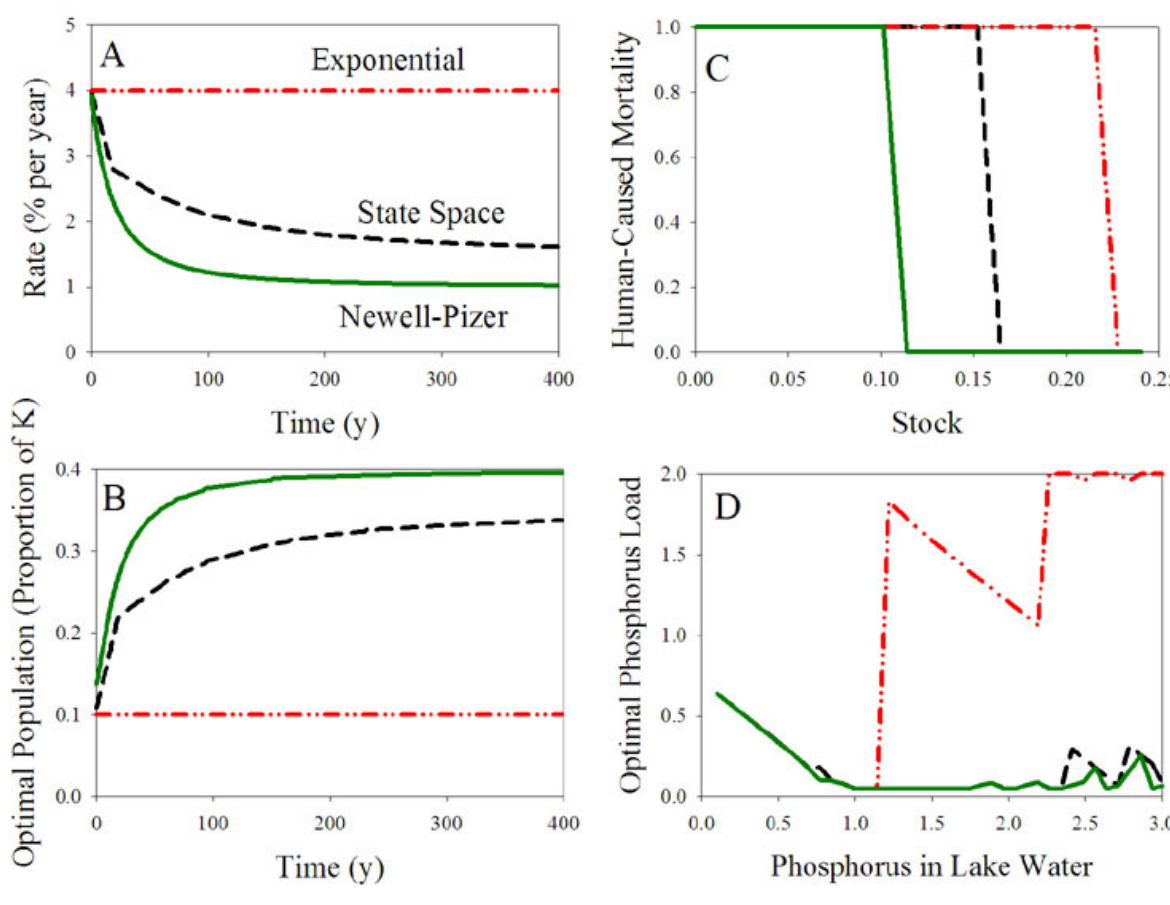
Fig. 2. (A) Discount rates vs. time according to three assumptions about future rates: constant rate of 4% (red dash-dot), State Space (black dash) and Newell and Pizer’s lower possibility (green solid). (B) Optimal population size as a function of time in the renewable resource example. (C) Human-caused mortality (proportion of population size) as a function of initial stock size, for optimal management of a hypothetical population of Atlantic right whales. (D) Phosphorus loading rate vs. initial phosphorus mass in the water of a lake, for optimal management of a lake subject to eutrophication if the phosphorus level passes a threshold (normalized to P =